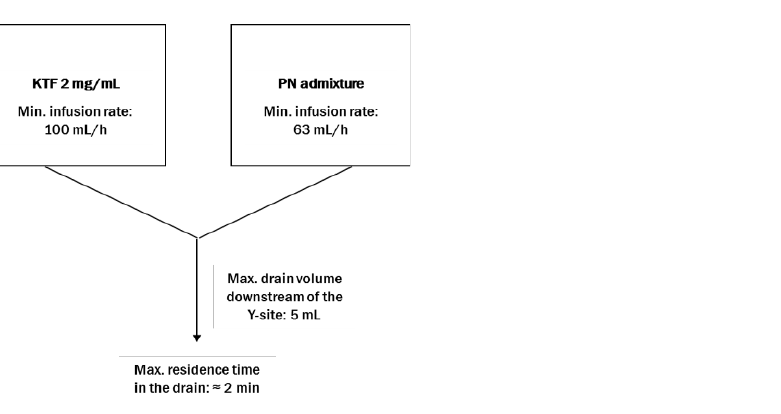
Figure 5. Diagram showing the method of calculating the maximum residence time in drain down- stream of the Y-site.